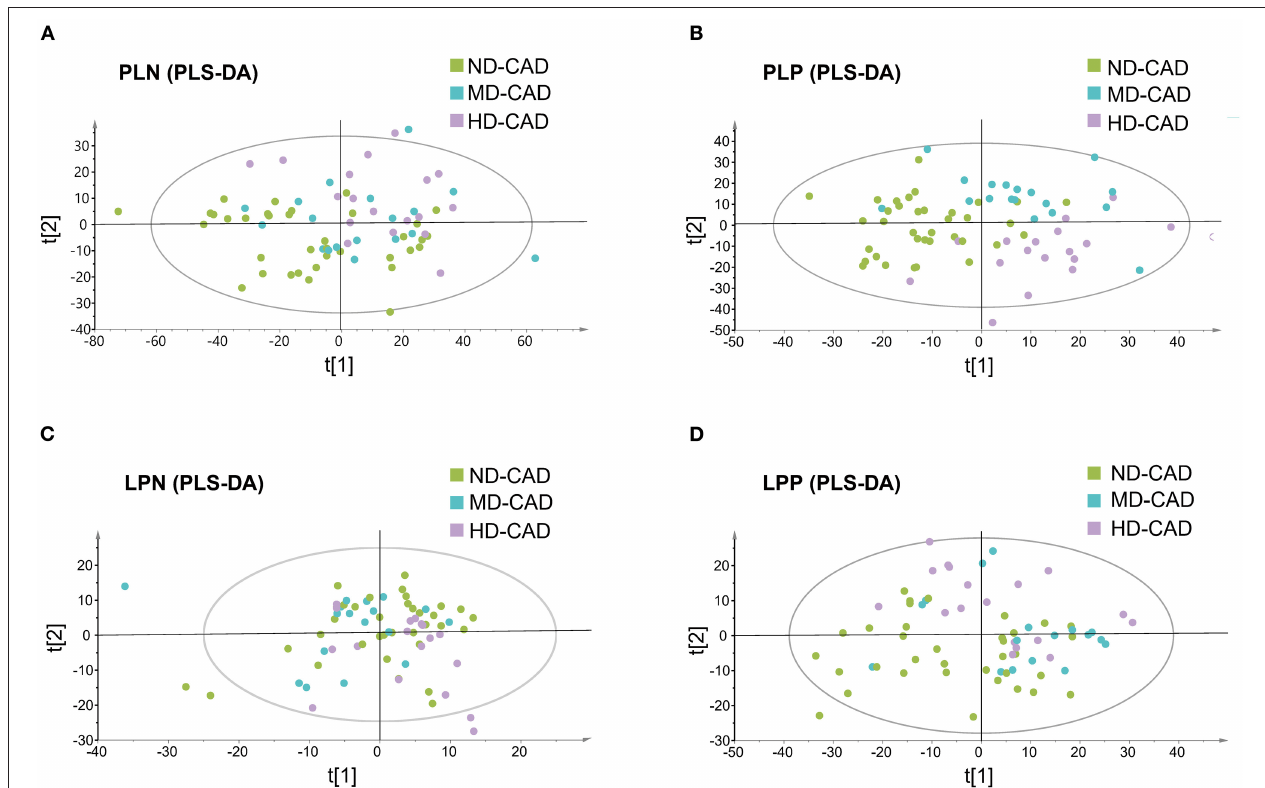
FIGURE 1 | Serum metabolites profiles of the patients with coronary artery disease with different alcohol consumption. (A–D) Separation of serum metabolites in polar ionic negative (PLN) mode, polar ionic positive (PLP) mode, lipid negative (LPN) mode, and lipid positive (LPP) mode, revealed by PLS-DA